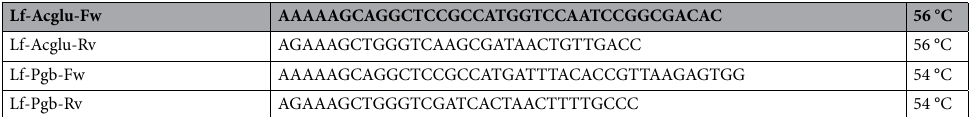
Table 1. Primers used to build the Entry library (Gateway) and their corresponding annealing